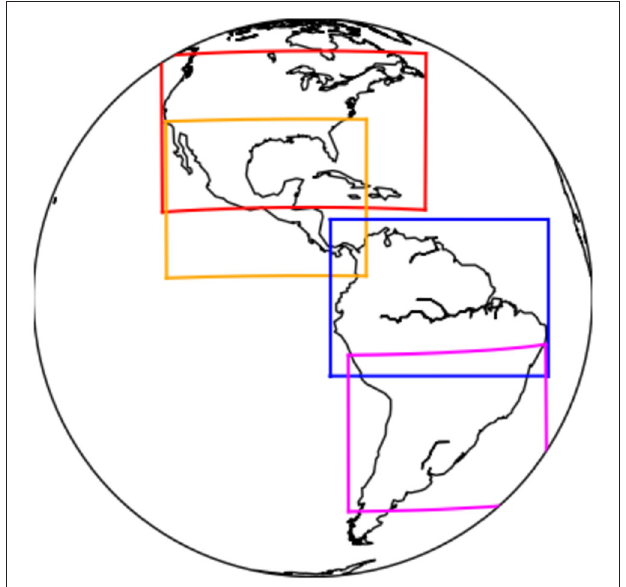
FIGURE 2 | Scan blocks used in regional OSSE experiments. The blocks are named for the region they primarily cover: Temperate North America (red), Tropical North America (orange), Tropical South America (blue), and Subtropical South America (magenta).